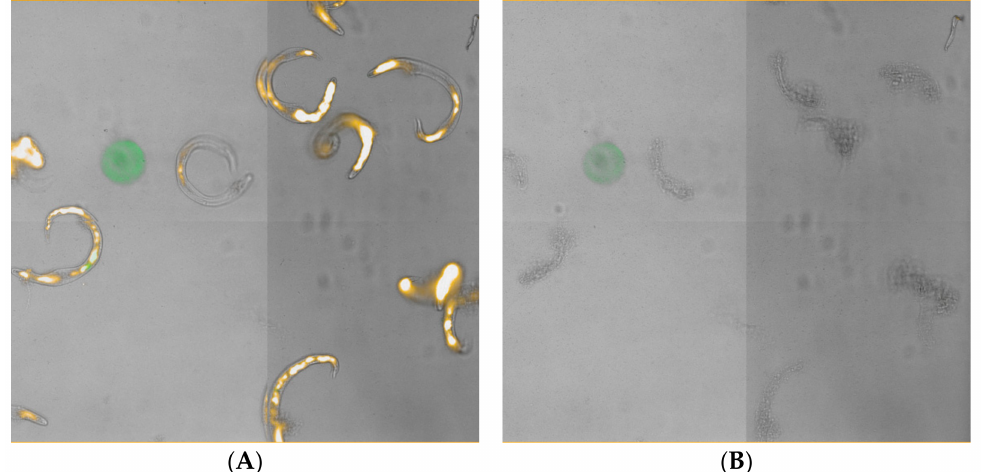
Figure 5. L3 under bright-field and PI illustrating rapid disintegration after ultrasound (2 min at 40 kHz) with the Branson 1510. ( A ) Day 0; note the punctuate fluorescence along the length of the nematode body. ( B ) Day 1, same view; note the loss of fluorescence and general deterioration of the nematode